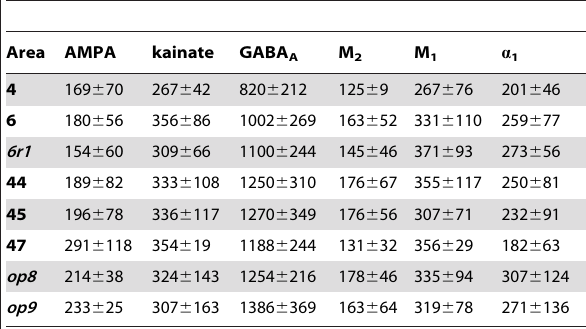
Table 2. Normalized receptor densities and standard deviations for each ligand and each area (averaged over all cortical